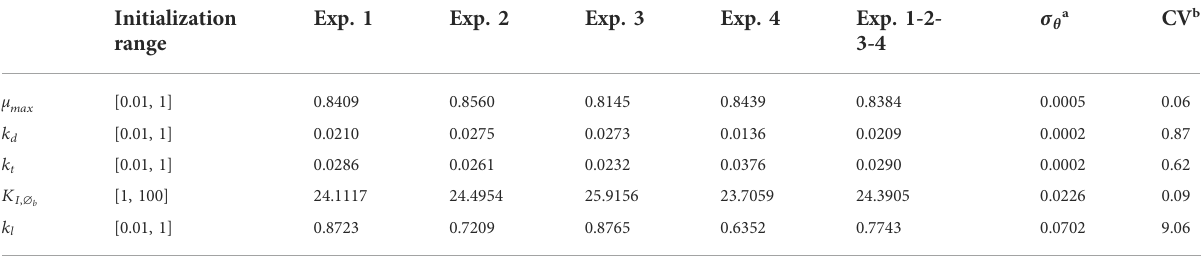
TABLE 1 Parameters values identi fi ed for each experiment separately and whole set of experiments 1 to 4.